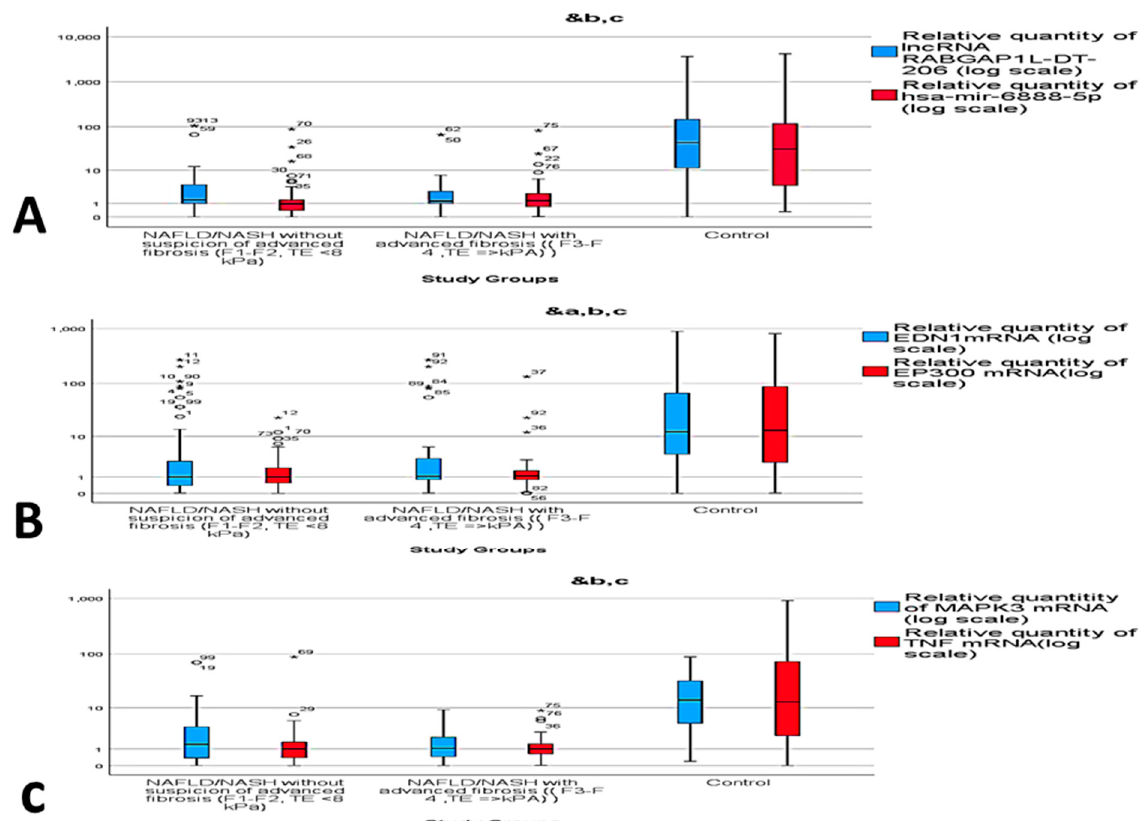
Figure 2. Relative expression of circulatory RNAs panel among the study groups. ( A ) lncRNA RABGAP1L-DT-206, hsa- miR-6888-5p, ( B ) EP300 mRNA, EDN1 mRNA and ( C ) TNF mRNA and MAPK3 mRNA. & Statistically significant difference by post Hoc (Turkey) test. a control vs. Group A, b control vs. Group B, c Group A vs. Group B. *, circle: represent